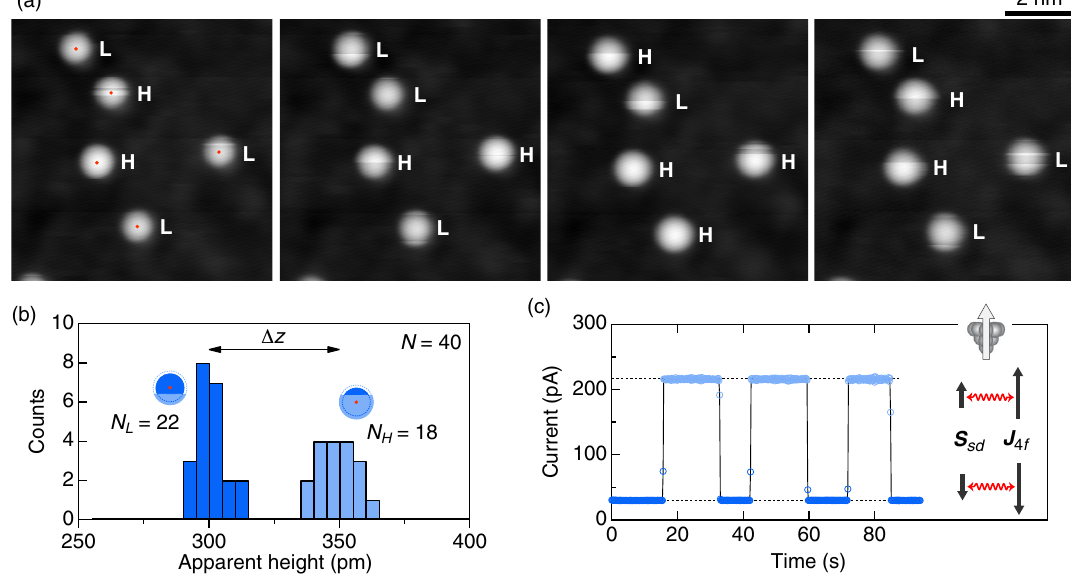
FIG. 4. Two-state telegraph signal in spin-polarized measurements for Dy = gr = Ir ð 111 Þ . (a) Sequence of constant current STM images showing Dy adatoms with switching apparent heights. H and L correspond to the height observed when scanning the protrusion center, ¼ þ 2 mV, I ¼ 20 pA, T ¼ 6 . 5 K). (b) Histogram deduced from the apparent height of the indicated by a red dot in the first frame ( V t t five atoms in a sequence of eight images. (c) Constant height current trace acquired on a Dy adatom displaying magnetoresistive contrast ¼ þ 1 mV, I ¼ 215 pA, I ¼ 30 pA, T ¼ 6 . 5 K). The sketch due to the thermally excited switching of the Dy magnetization ( V t high low represents the Dy magnetization in the two degenerate states of the ground doublet with respect to the tip magnetization. All data were acquired using a Mn 88 Ni 12